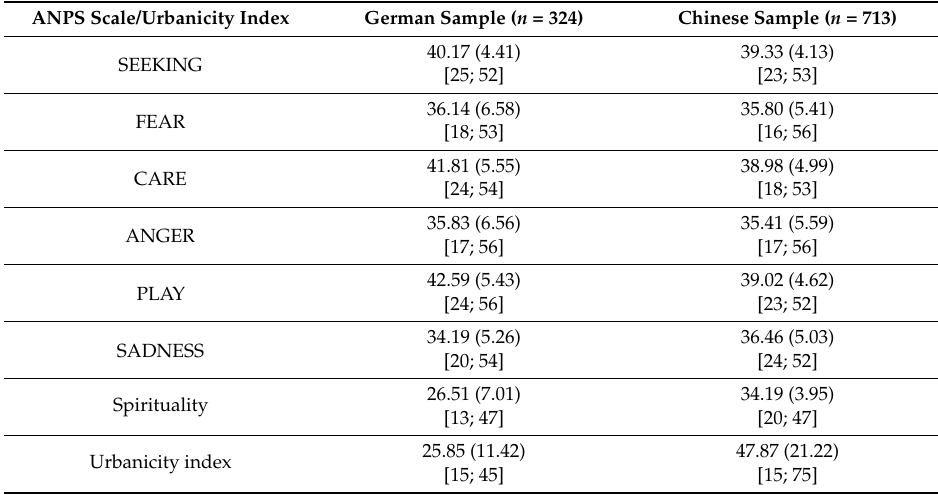
Table 3. Means (SDs) and [observed range] of all variables of interest separately for the samples from Germany and